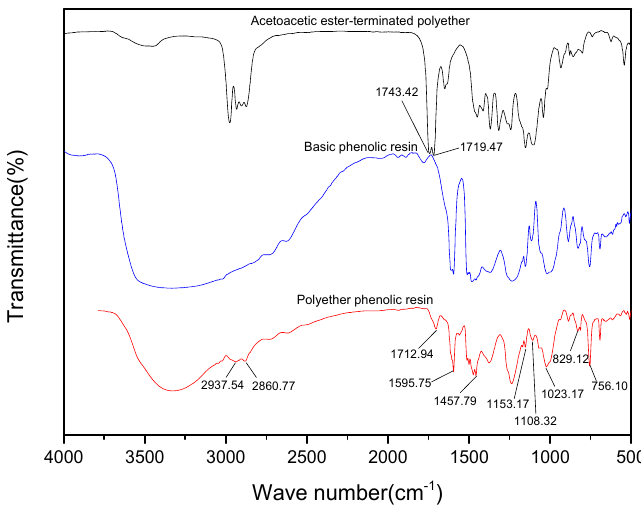
Figure 1. The Fourier transform infrared spectroscopy (FT-IR) spectra of the phenolic resin and acetoacetic ester-terminated polyether.